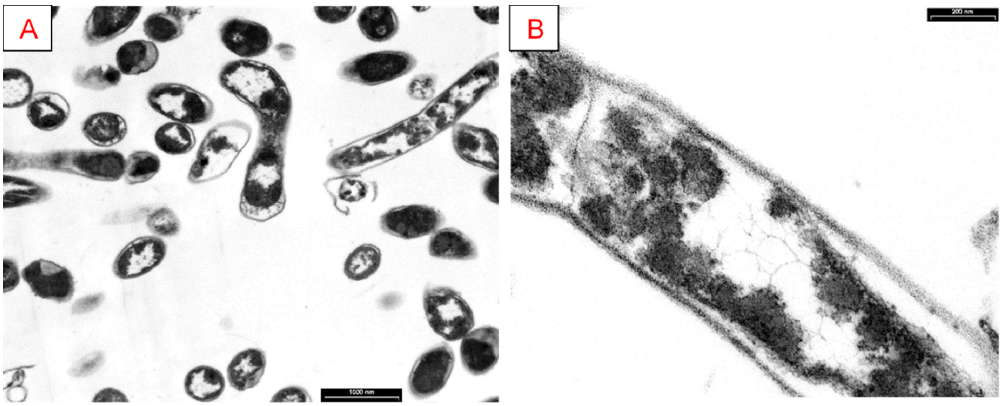
Figure 5. TEM images of G. stearothermophilus GF16 in exponential phase at different scales (black bars): ( A ) 1000 nm; ( B ) 200 nm. ( A ) 1000 nm; ( B ) 200 nm.